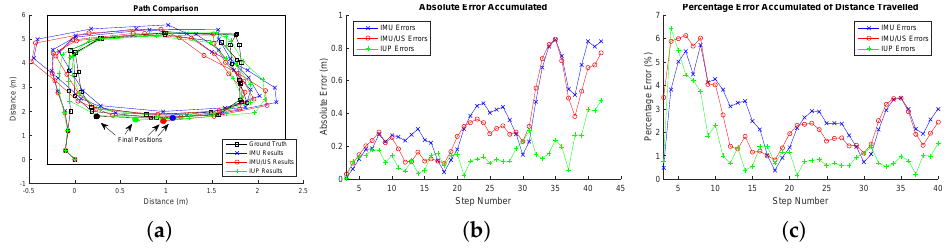
Figure A2. ( a ) The tracked walking paths by the inertial measurement unit (IMU), IMU/ultrasound (US) and inertial/ultrasound/particle filter (IUP) systems for trial 3 of Type 1 walking compared to the ground truth position measured simultaneously by a Vicon motion capture system. ( b ) The absolute errors of the IMU, IMU/US and IUP systems at each single step for trial 3 of Type 1 walking. ( c ) The percentage errors of the IMU, IMU/US and IUP systems at each step for trial 3 of Type 1 walking. In this trial, the percentage error was initially high. This was probably due to the error accumulation in the first step. However, we can see a drop off in the percentage error as the periodic walking pattern